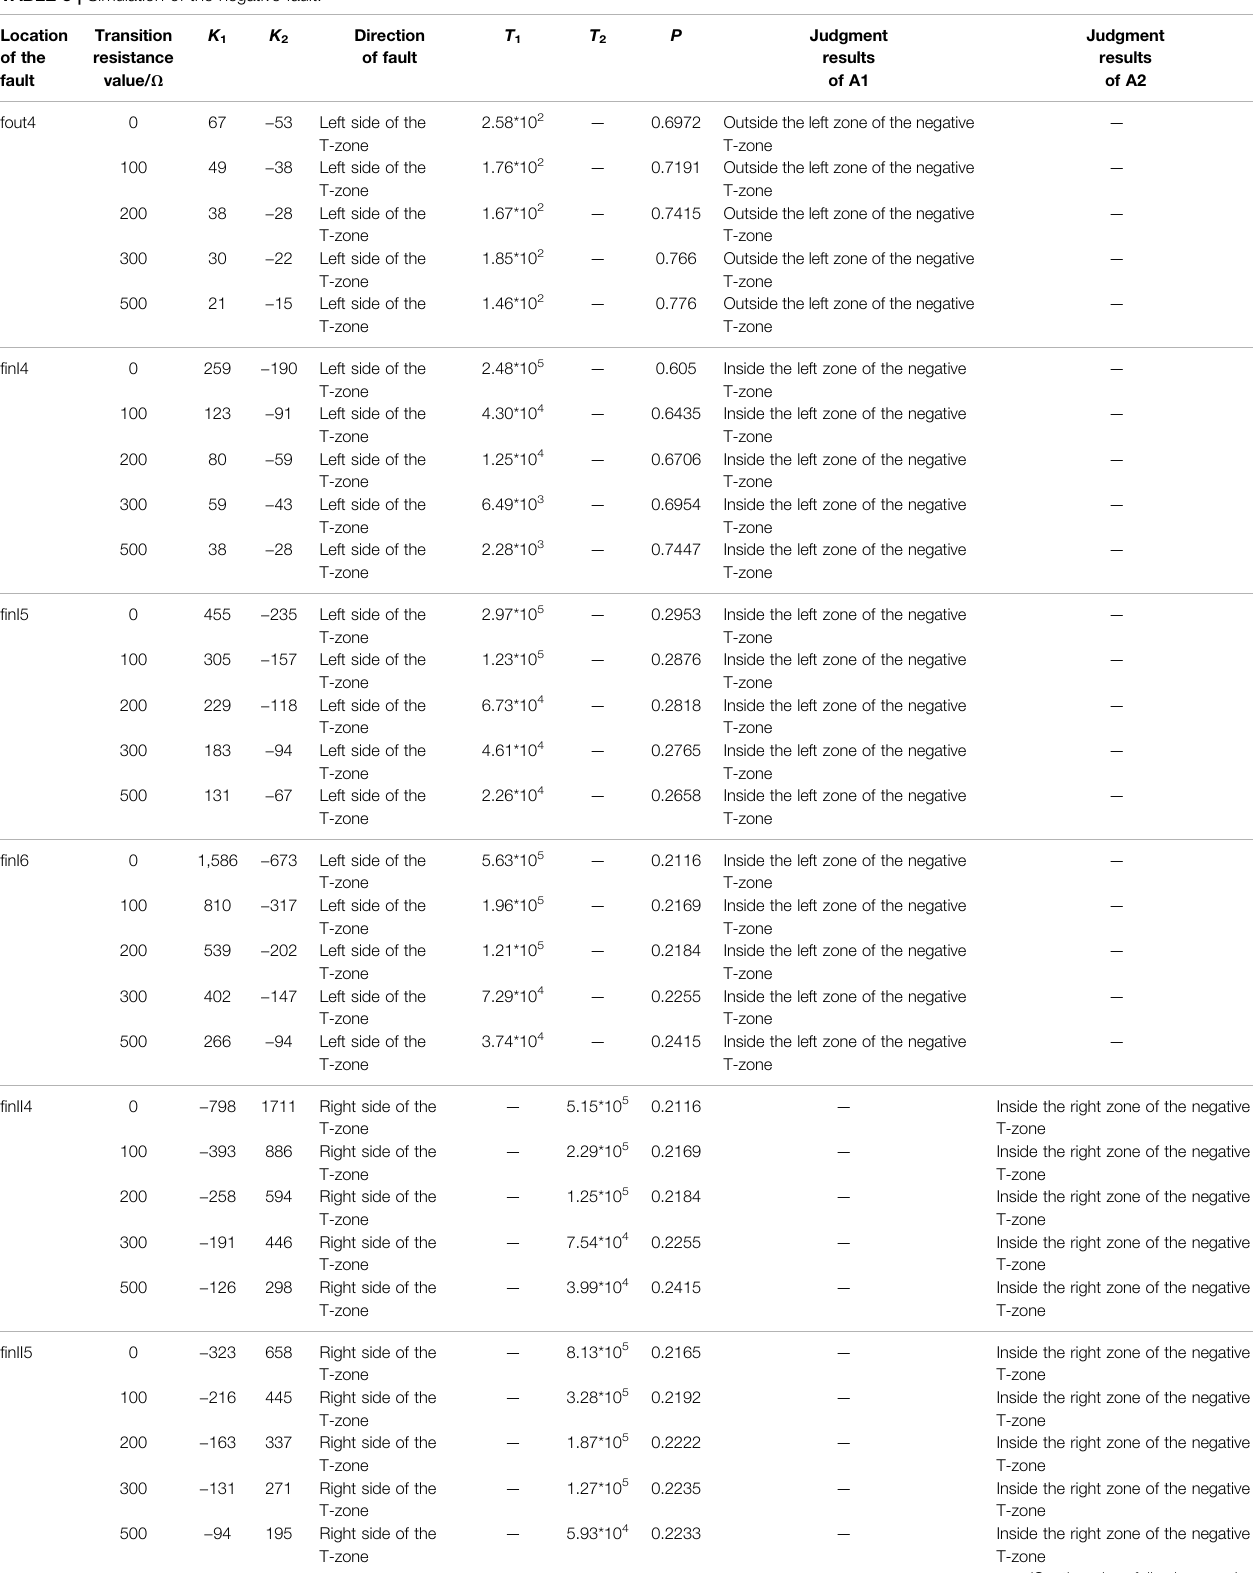
TABLE 3 | Simulation of the negative fault. Location of the